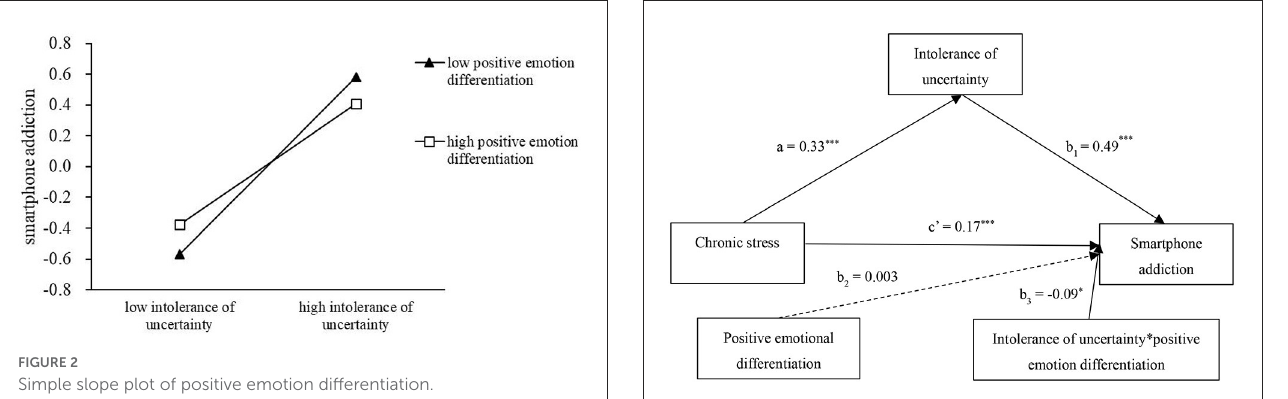
FIGURE3 Statistic